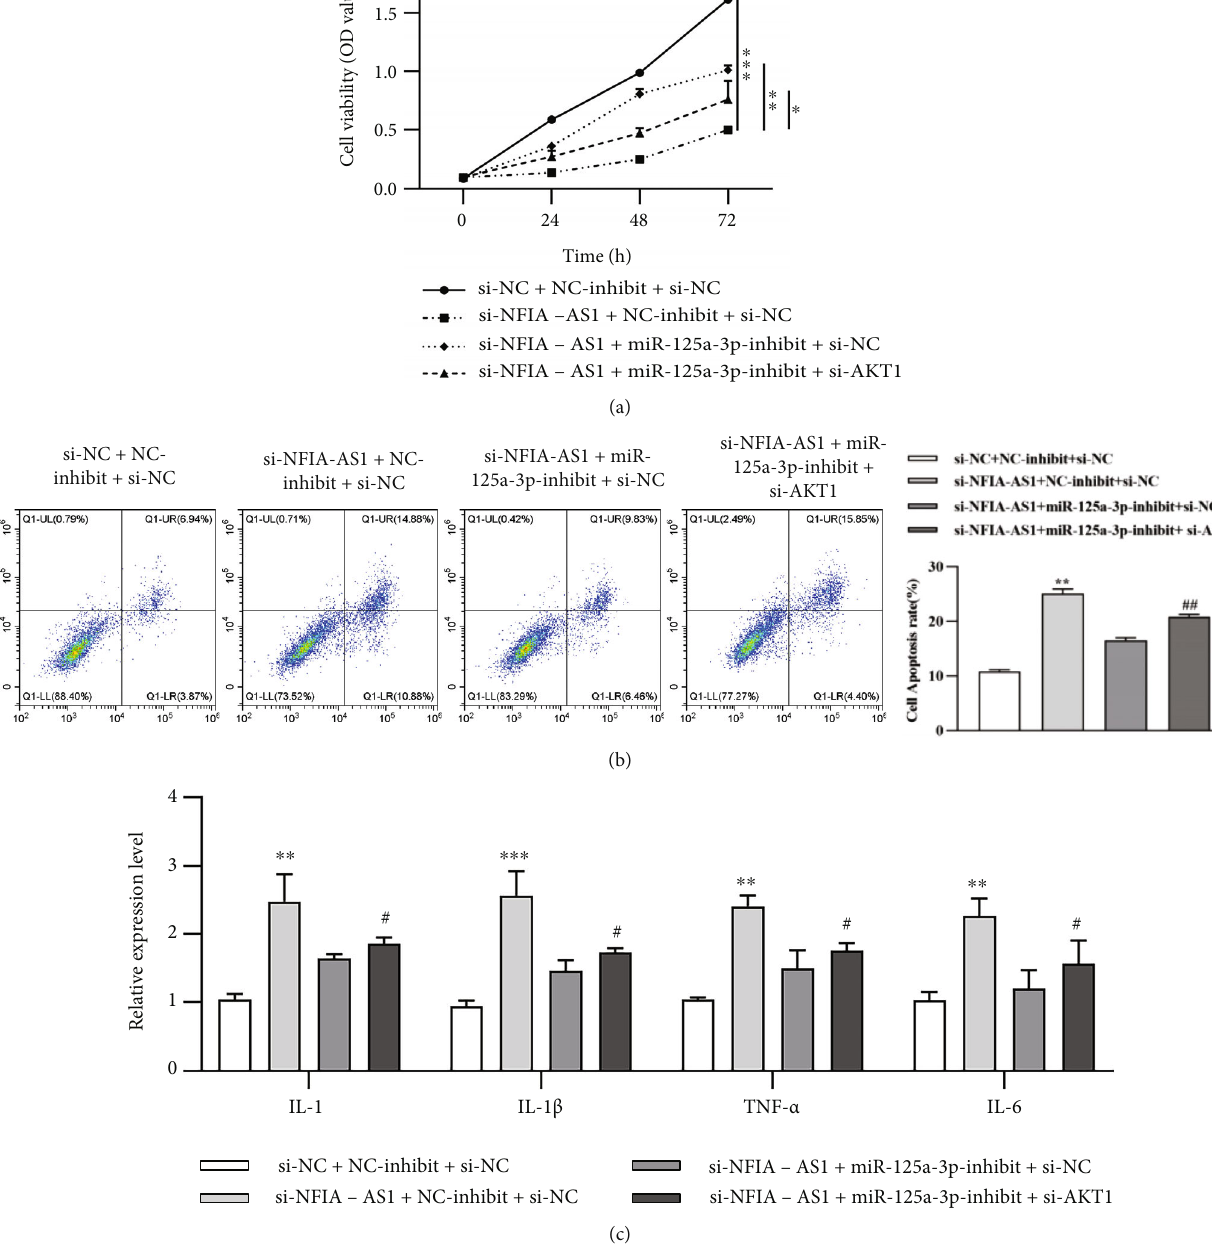
Figure 6: Inhibition of NFIA-AS1 alleviates the proliferation and in fl ammation of Ox-LDL-induced VSMCs by regulating miR-125a-3p/ AKT1 axis. Ox-LDL-induced VSMCs were divided into four groups: si-NC +NC-inhibit+ si-NC, si-NFIA-AS1+NC-inhibit+ si-NC, si- NFIA-AS1 +miR-125a-3p-inhibit+si-NC, and si-NFIA-AS1 +miR-125a-3p-inhibit+si-AKT1. (a) Cell viability was detected via CCK-8 assay. * P < 0 : 05 , ** P < 0 : 01 , and *** P < 0 : 001 . (b) Cells were stained with PI and the apoptosis rate was detected by fl ow cytometry. (c) The level of in fl ammatory cytokines was assessed by ELISA. ** P < 0 : 01 and *** P < 0 : 001 versus si-NC+ NC-inhibit+si-NC group. # P < 0 : 05 and ## P < 0 : 01 versus si-NFIA-AS1+miR-125a-3p-inhibit+si-NC group. All results were obtained from three independent